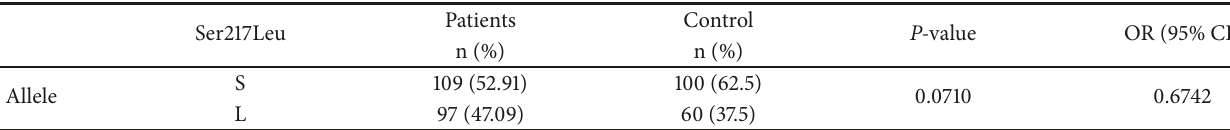
Figure 3: Agarose gel electrophoregram of representative results of the digestion of the ELAC2 gene with Taq 𝛼 1. SS represents the wild-type genotype,SLtheheterozygousgenotypeandLLthemutantgenotype.Lanes50-61representtheELAC2genedigestsfromvariousparticipants. Lane M is the 50bp molecular weight marker. Numbers (50-61) represent various participants’ laboratory codes. Table 2: Allelic frequencies of the ELAC2 gene in the study participants.